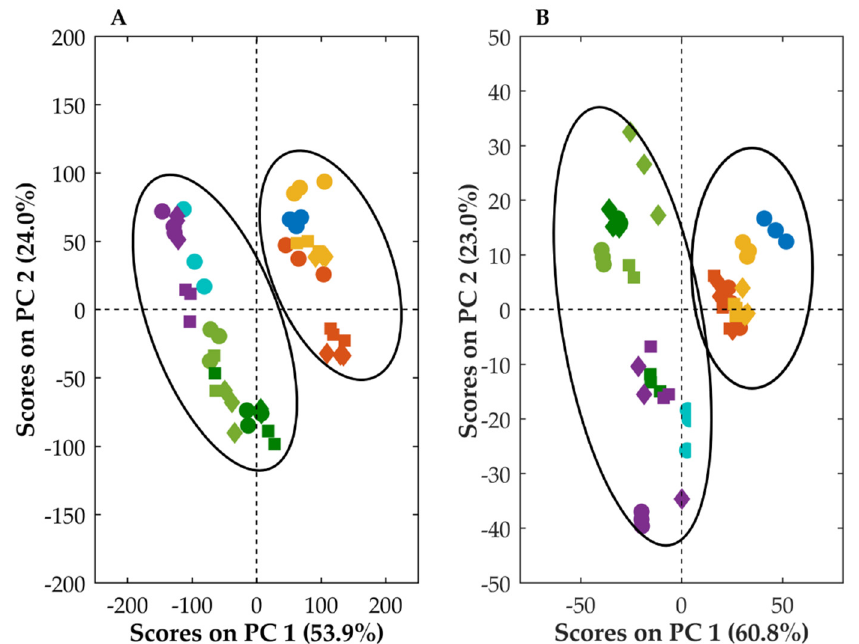
Figure 8. Principal component analysis conducted on the Fourier-transformed mid ( A ) and near ( B ) infrared spectral data of formulations containing crystalline olanzapine and saccharin in a physical mixture (dark blue) and in granules (5, yellow, 10, orange, 15, dark green and 25%, light green, of water) and to formulations containing co-amorphous olanzapine and saccharin, after physical mixture (light blue) and granulation using 10% of water (purple). Drying temperature applied to samples: 40 °C (circle), 65 °C (square) and 90 °C (diamond).